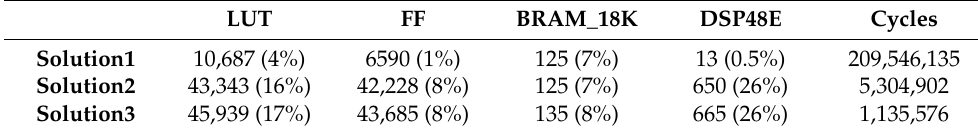
Table 2. FPGA resources and performances of the MLVMF-designed